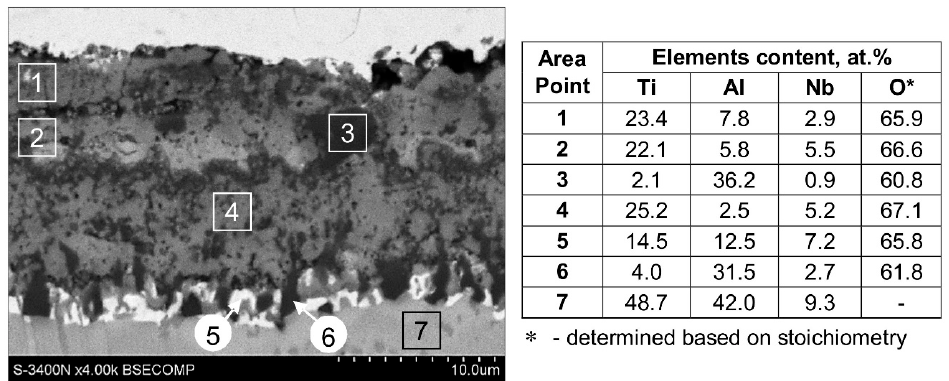
Figure 10. The microstructure (SEM) and EDS results (point 1–7) of the oxide scale formed on Ti–45Al–8Nb–0.5(B, C) alloy during 25 cycles of isothermal oxidation at 950 °C.